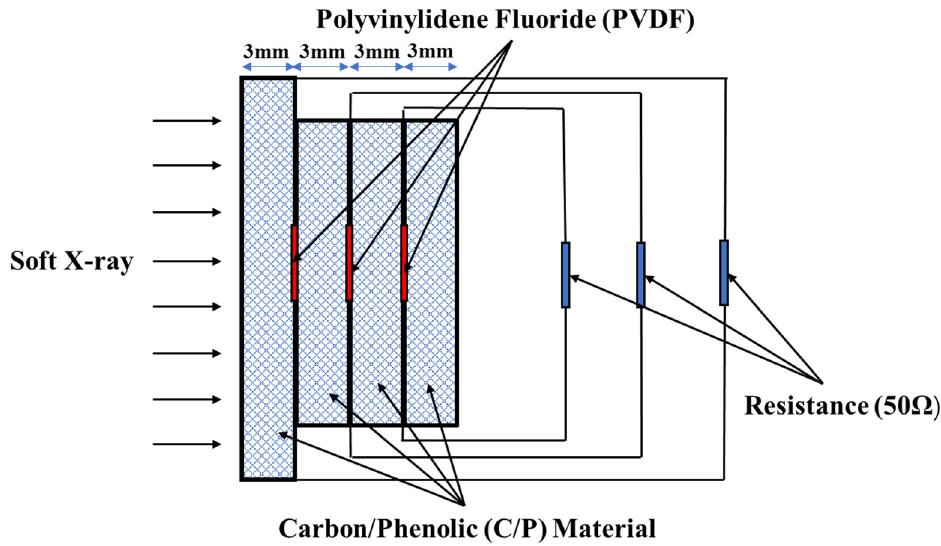
Figure 2. A schematic diagram of PVDF thermal shock wave stress measurement.